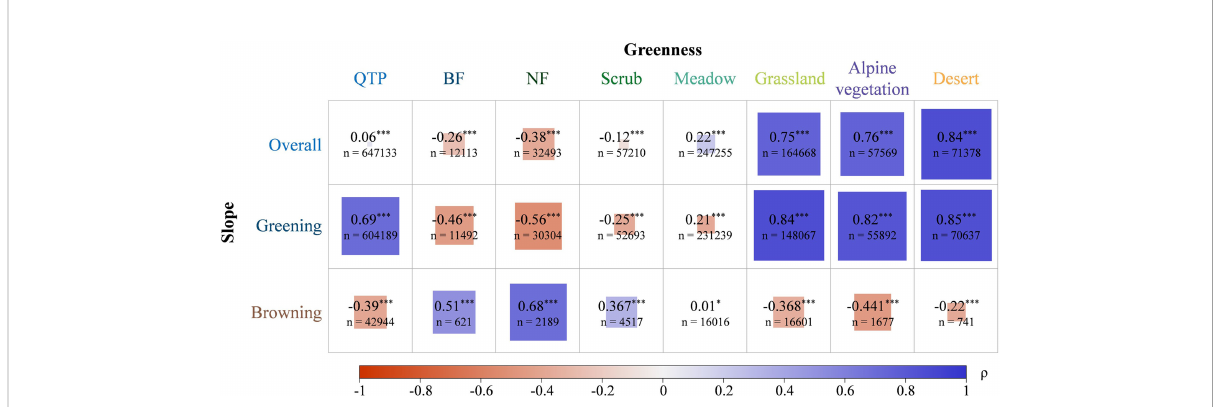
FIGURE 8 Spearman coef fi cients between vegetation greenness and change trend. Slope of greening is greater than 0, and slope of browning is less than 0. *** and * represent signi fi cant at 99% and 90% con fi dence levels, respectively. The absolute value of Spearman ’ s coef fi cient r is divided into fi ve ranges: 1.0 ≥ |p| >0.8 (very strong correlation), 0.8 ≥ |p| >0.6 (strong correlation), 0.6 ≥ |p| >0.4 (moderate correlation), 0.4 ≥ |p| >0.2 (weak correlation), and 0.2 ≥ |p| ≥ 0 (very weak